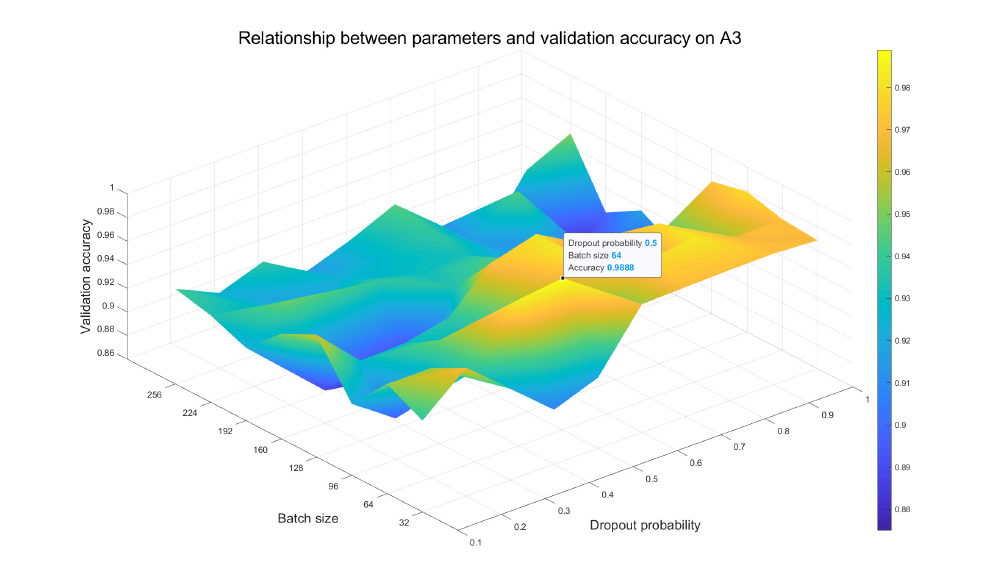
Figure 12. Surface plot on the A3 model displaying the resulting validation recognition accuracy for different choices of values of the batch size and the dropout probability.